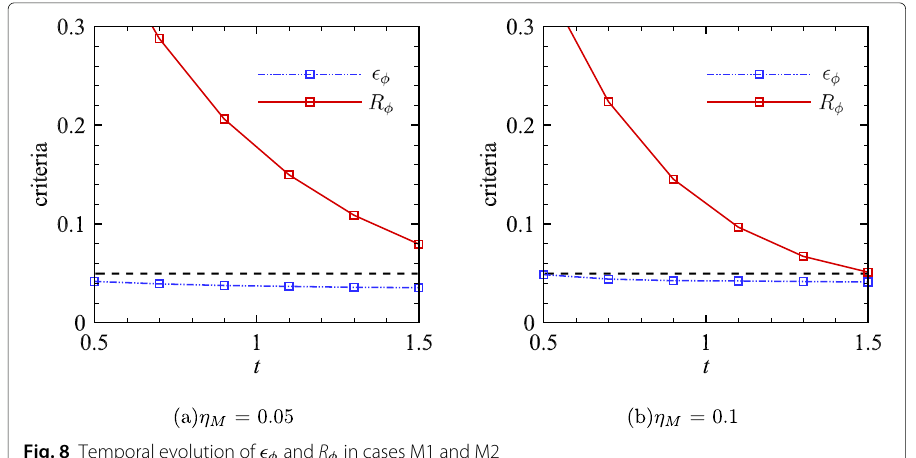
Fig. 8 Temporal evolution of (cid:12) φ and R φ in cases M1 and